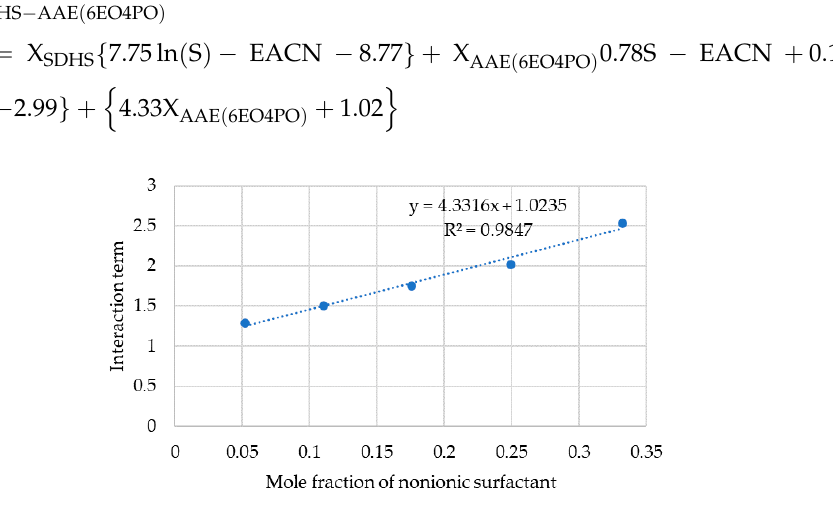
Figure 8. The average interaction terms of each anionic–nonionic ratio of SDHS-AAE(6EO4PO)